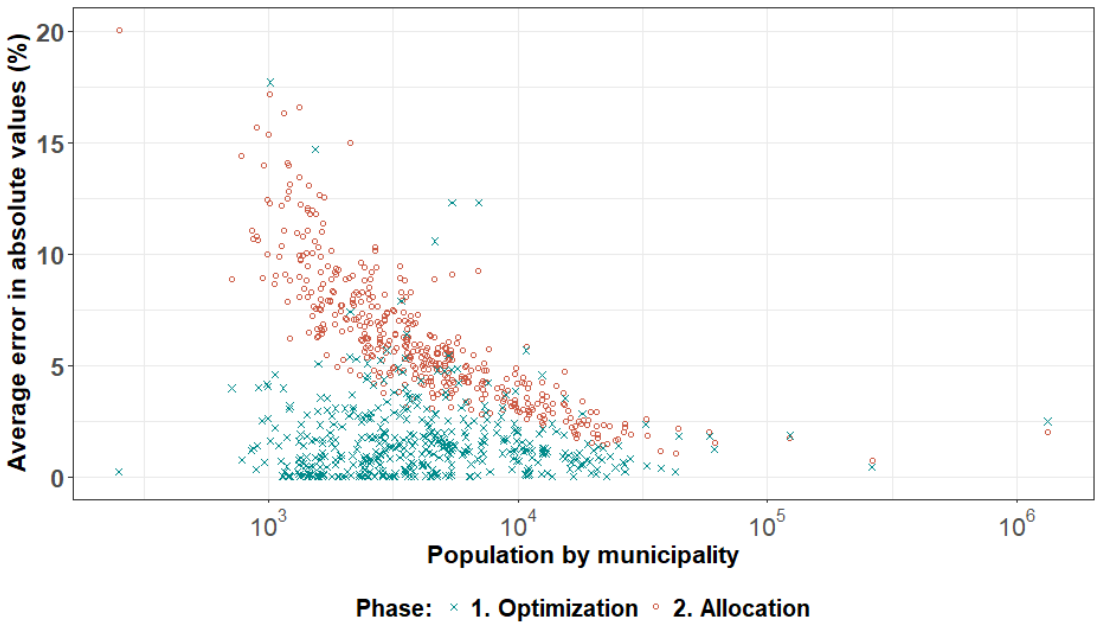
Figure 3. Average error (%) per municipality at the optimization and allocation phase.